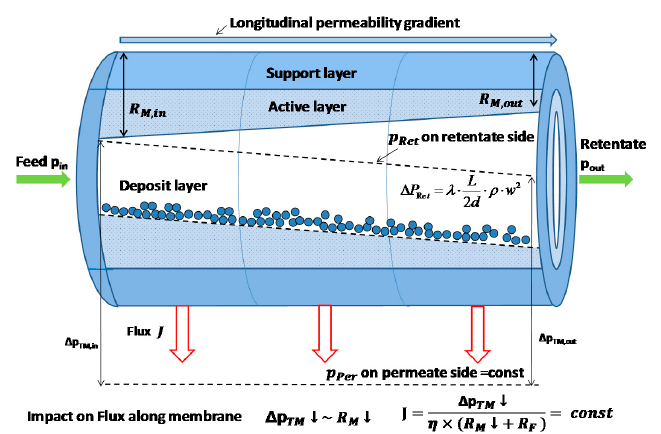
Scheme 2. Schematic description of the used gradient membrane. Concept of TAMI Industries, modified from [35]. Flux J, transmembrane pressure Δ p TM , dynamic viscosity η , membrane resistance